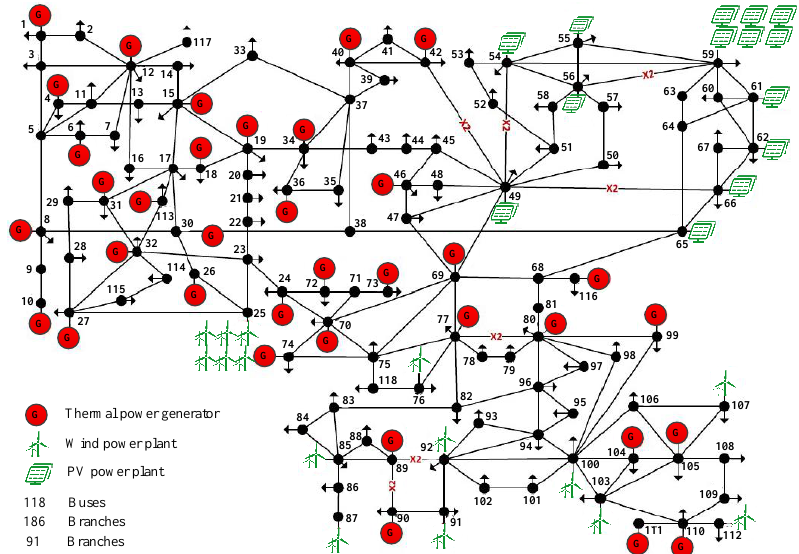
Figure 5. New England 118 bus system.